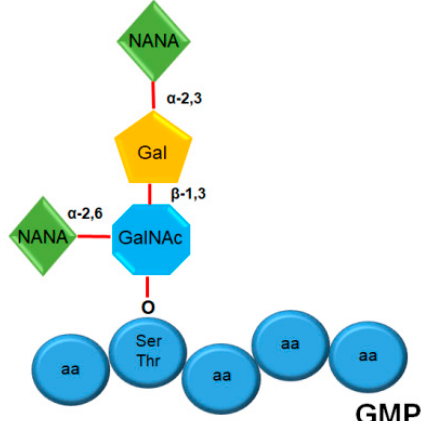
Figure 2. Structure of O -linked tetrasaccharides of glycomacropeptide. The image depicts the most abundant oligosaccharide structure in glycomacropeptide (GMP), where N -acetylgalactosamine (GalNAc) is O -linked to serine (Ser) or threonine (Thr), which is respectively bonded via α -2,6 and β -1,3 bonds to N -acetylneuraminyl or sialic acid (NANA) and galactosyl (Gal); in turn, Gal is linked via an α -2,3 bond to NANA. aa, amino